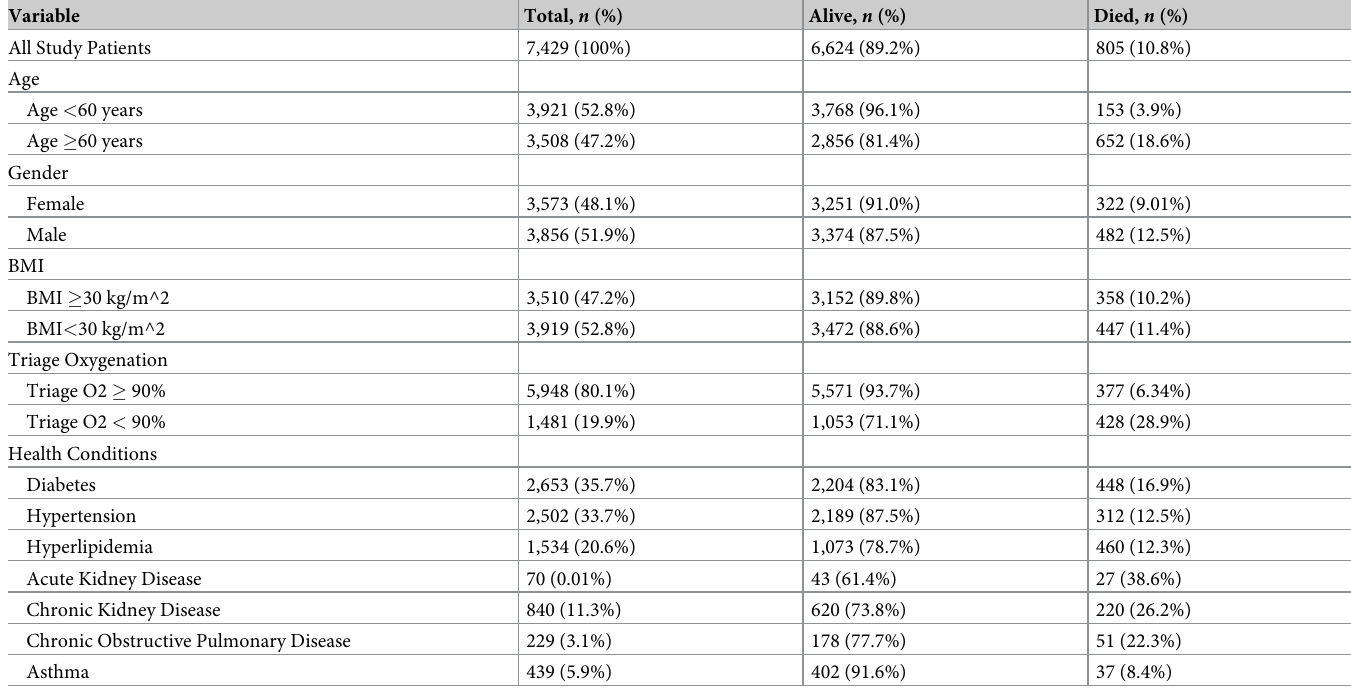
Table 1. Descriptive characteristics of study patients (n = 7,429), demographics, and survival